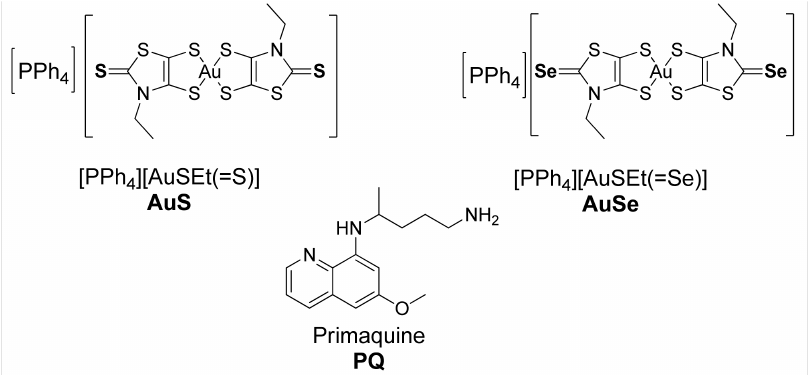
Figure 1. Chemical structures of the gold complexes, AuS and AuSe, and the reference drug